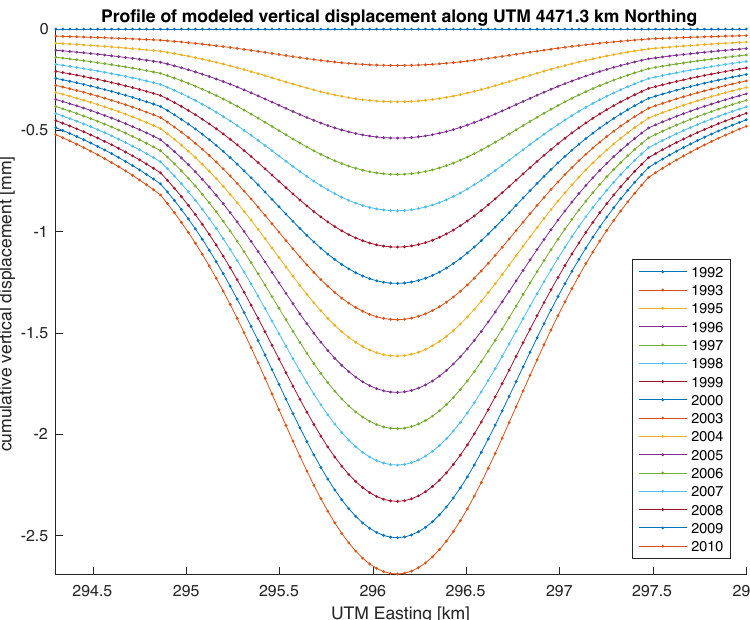
Figure 5. ( top ) schematic showing best-fitting cuboid model in cross-section (UTM northing vs. elevation/depth). ( bottom ) Profile of modeled cumulative displacement derived from the best-fitting cuboidal model along the profile line UTM Northing = 4471.3 km.